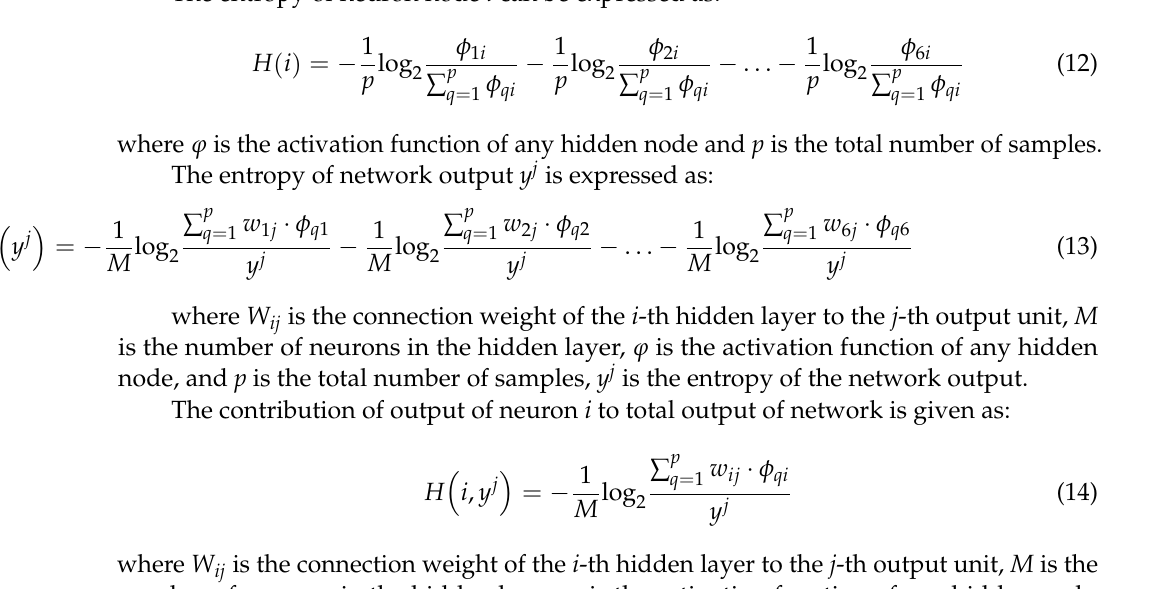
Figure 5. Composition of output neuron j.